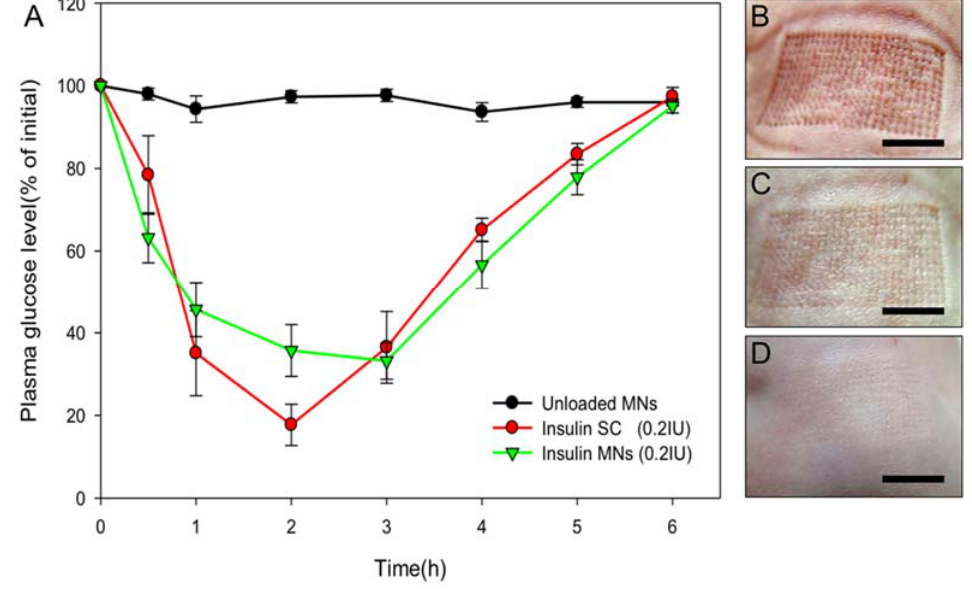
Figure 5. ( A ) Plasma glucose level changes over time in db / db mice after receiving an unloaded or insulin-loaded MN patches or a subcutaneous injection of insulin. (n = 6 per group). Skin puncture marks after ( B ) 10 min, ( C ) 1 h, and ( D ) 3 h. Scale bar = 5 mm.